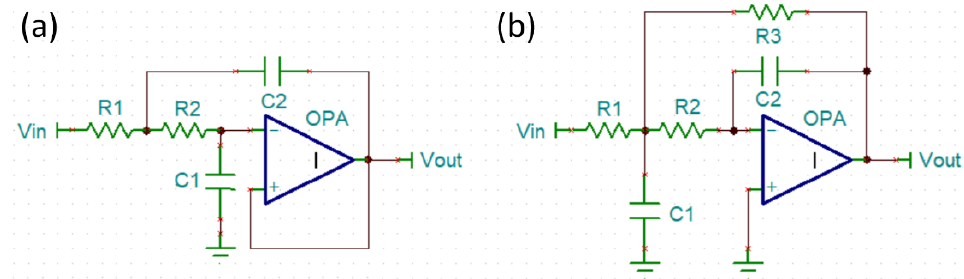
Figure 3. ( a ) Sallen – Key filter architecture ( b ) MFB filter architecture.